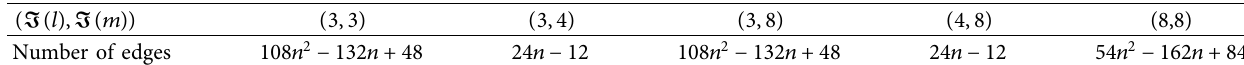
Figure 2: Benzenoid dominating planar octahedron structure of dimension 2. Table 2: Edge partition of benzenoid dominating planar octahedron